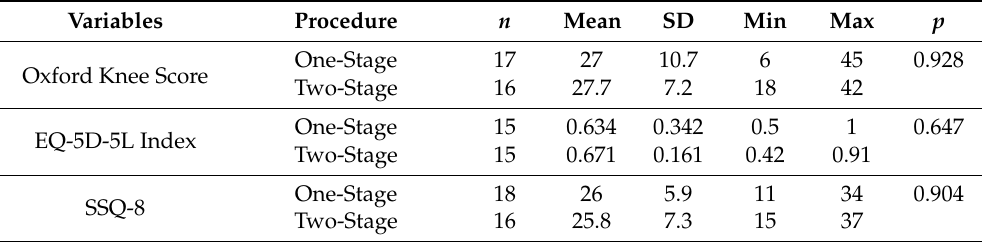
Table 4. Descriptive statistics: Oxford Knee Score, EQ-5D-5L Index, and SSQ8.